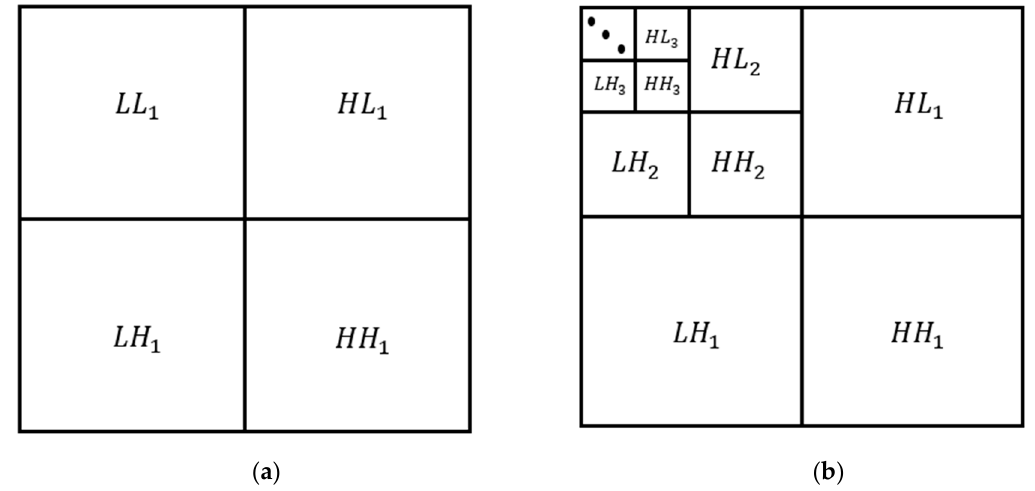
Figure 3. The scale decomposition of discrete wavelet transforms: ( a ) the first scale decomposition of a discrete wavelet transform representing each wavelet coe ffi cient in a spatial area corresponding to approximately a 2 × 2 area of the original image and ( b ) an n-scale wavelet decomposition. The image is divided into four di ff erent sub-bands based on their frequency. Each coe ffi cient in the sub-bands of the second scale HH 2 , LH 2 , HL 2 , and LL 2 represent a spatial area corresponding to approximately a 2 2 × 2 2 area of the original image.